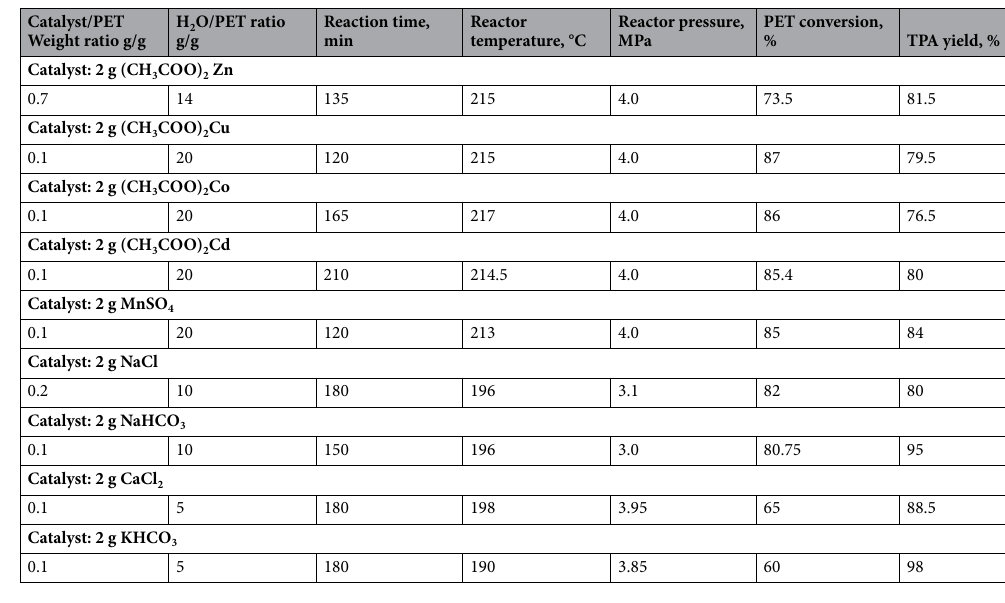
Table 2. Experimental data of PET depolymerization by hydrolysis using a single catalyst.